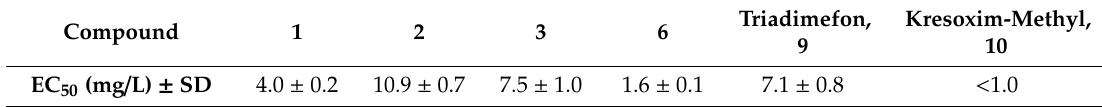
Table 2. Fungicidal activity (EC 50 ) of peroxides ( 1 – 3 , 6 ) and the reference compounds. Compound